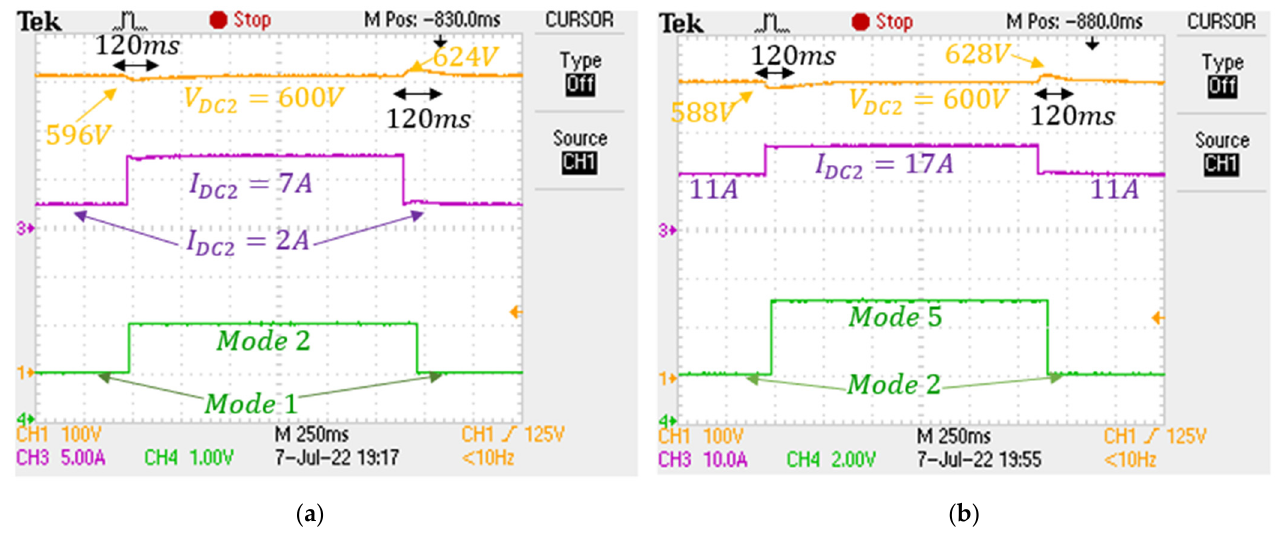
Figure 18. Transient behavior ( a ) mode 1 to mode 2 ( b ), mode 2 to mode 5.